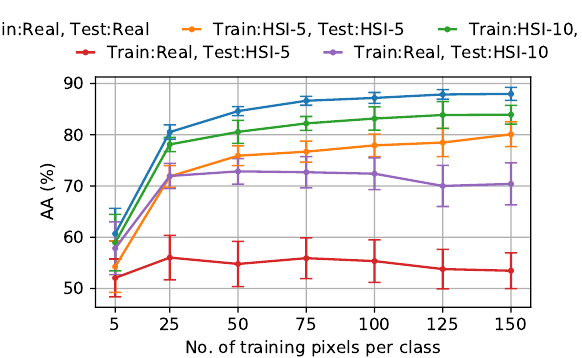
Figure 12. Average accuracy as a function of training set size for different models trained on land cover classification dataset.